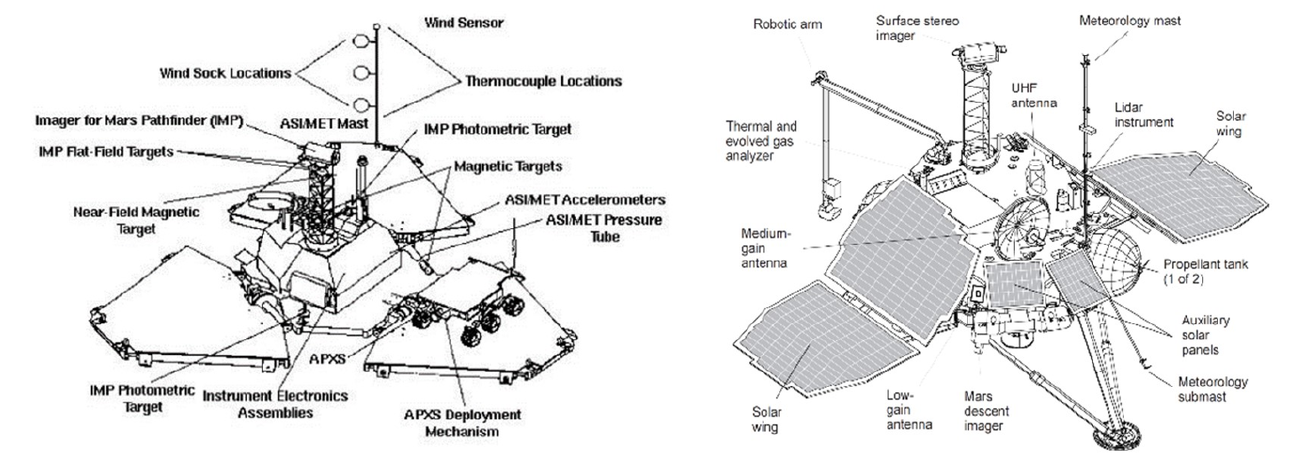
Figure 3. Mars Pathfinder Lander Configuration [17] ( left ). MarsPolar Lander diagram [18] ( right ).